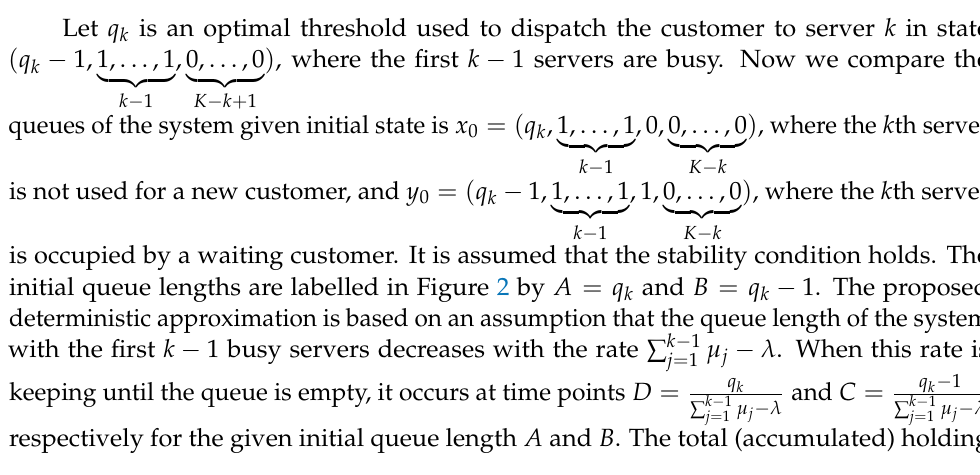
Figure 2. Queue length